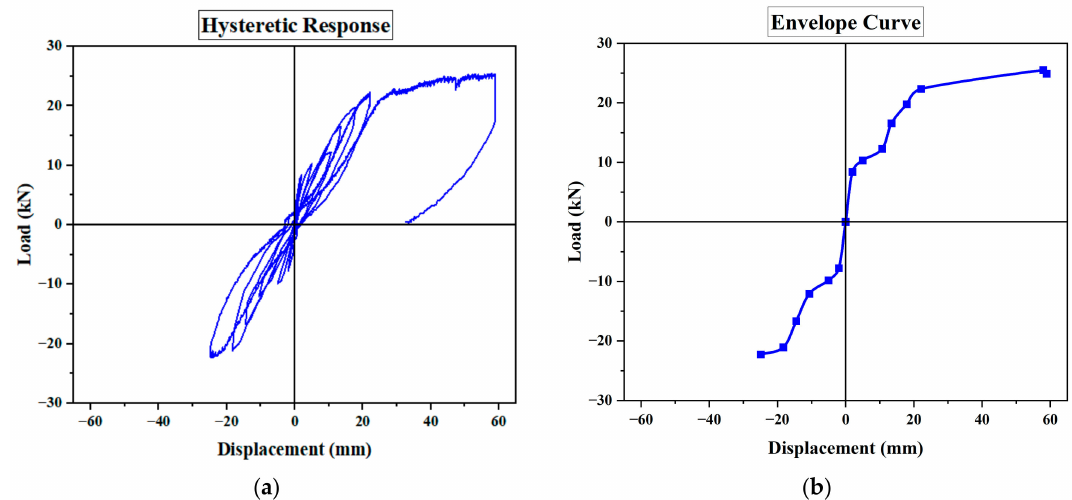
Figure 7. Experimental results of GPC-BF ( a ) Hysteretic response ( b ) Envelope